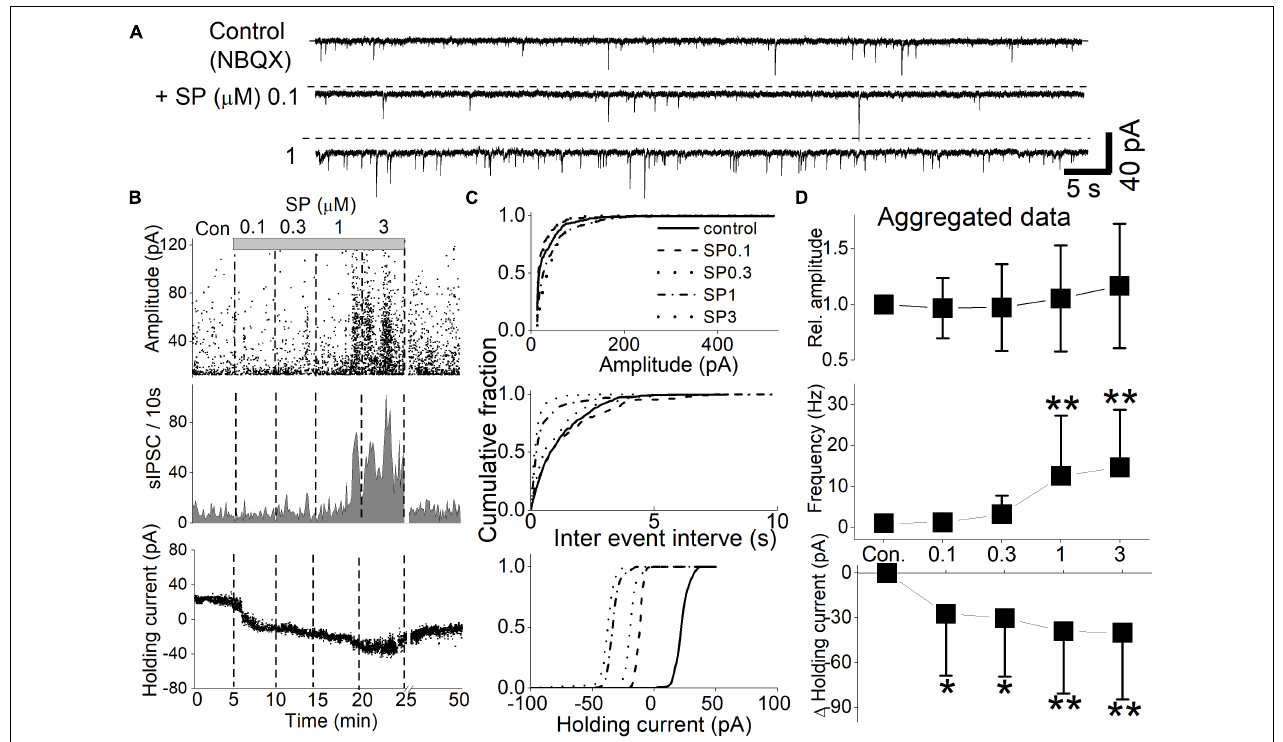
FIGURE 2 | Concentration-dependent SP effect on sIPSCs and holding currents. sIPSCs were isolated by the continuous presence of NBQX (20 µ M) at a holding potential of -50 mV. SP (0.1–3 µ M) was applied in a cumulating manner. The slices were washed with ACSF for 1 min before higher concentrations of SP ware applied. (A) The holding current increased proportionally with the SP concentration. Additionally, the frequency of sIPSCs increased at 1 µ M SP. The dashed line indicates the mean holding current before SP treatment. (B) Diary plots display the event characteristics of the sIPSCs of representative neurons (upper traces) during the cumulative application of 0.1–3 µ M SP. The amplitude (top panel), frequency (middle panel), and holding current (bottom panel) for each detected sIPSC are displayed. (C) Corresponding cumulative fractions of event measurements shown for the individual sIPSCs in panel (B) . The subpanels show the effect of SP on sIPSC amplitude (top panel), interevent interval (middle panel) and holding current (bottom panel). The baseline holding currents were measured as the absolute current (pA) of the individual responses. (D) Summary aggregate data for sIPSC events and concurrent changes in the holding current recorded during application of NBQX ( n = 9 to 8 neurons). Measurements were normalized by the control amplitude and frequency of the neurons before compiling the averages. Changes in the baseline holding currents were calculated as changes from the control condition in absolute